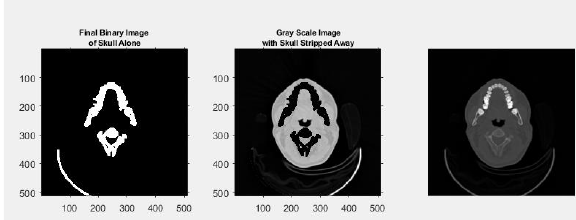
Fig. 2. The figure shows the process of removing bone structures from a CT image based on the calculated threshold. On the left side, there is a bone tissue found in the CT scan image presented. In the middle, the picture shows the image with merged tissue cut out, i.e., only soft tissues in which the existence of a tumor is possible. On the right side, there is shown an original unprocessed image.